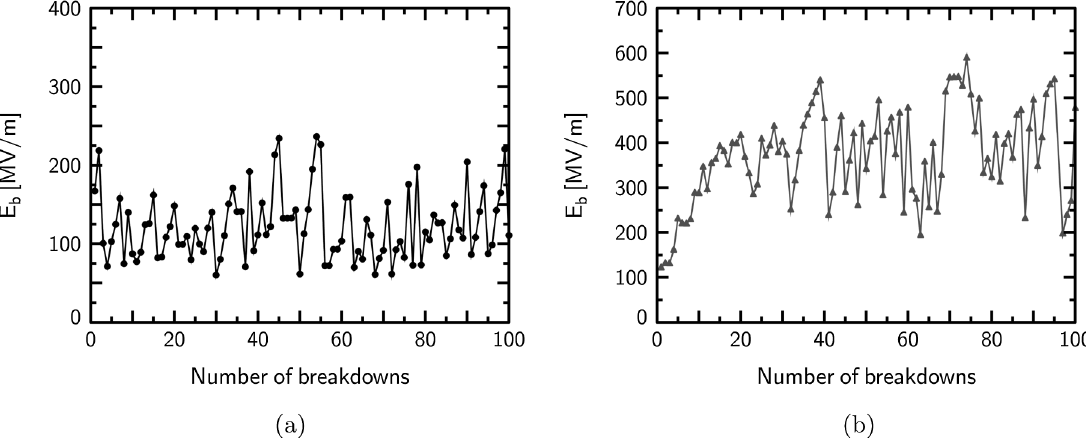
FIG. 4. Typical processing curves measured with C 1 ¼ 27 : 5 nF (corresponding to the order of (cid:2) 0 : 1 – 1 J ). E sat is the average of E b excluding the processing phase, that is, the first 10 sparks for Cu and the first 40 sparks for Mo, and the error is the standard error of the same data points. (a) Cu, E sat ¼ ð 121 (cid:1) 4 Þ MV = m . (b) Mo, E sat ¼ ð 403 (cid:1) 9 Þ MV = m